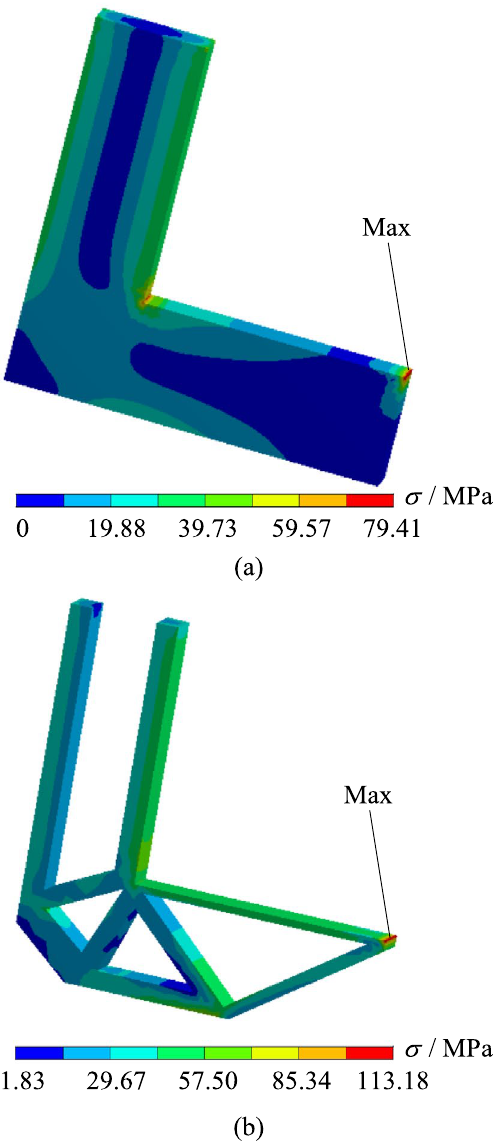
Figure 7. Comparison of stress contour figures before and after optimization. ( a ) Stress contour figure of the original model ( b ) Stress contour figure of the reconstructed